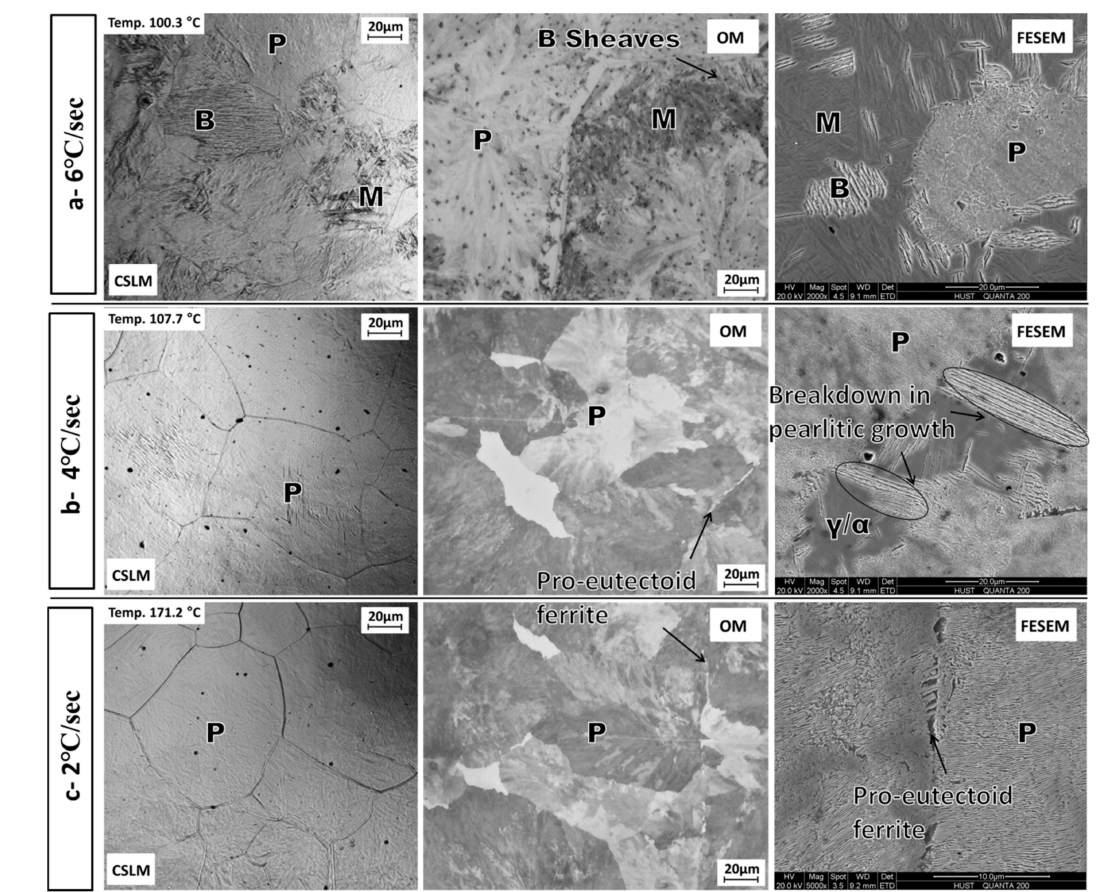
Figure 5. Microstructure obtained under di ff erent cooling rates. P: pearlite, B: Bainite, M: Martensite, γ / α : Austenite / Ferrite. ( a ) 6 ◦ C / s; ( b ) 4 ◦ C / s; ( c ) 2 ◦ C /